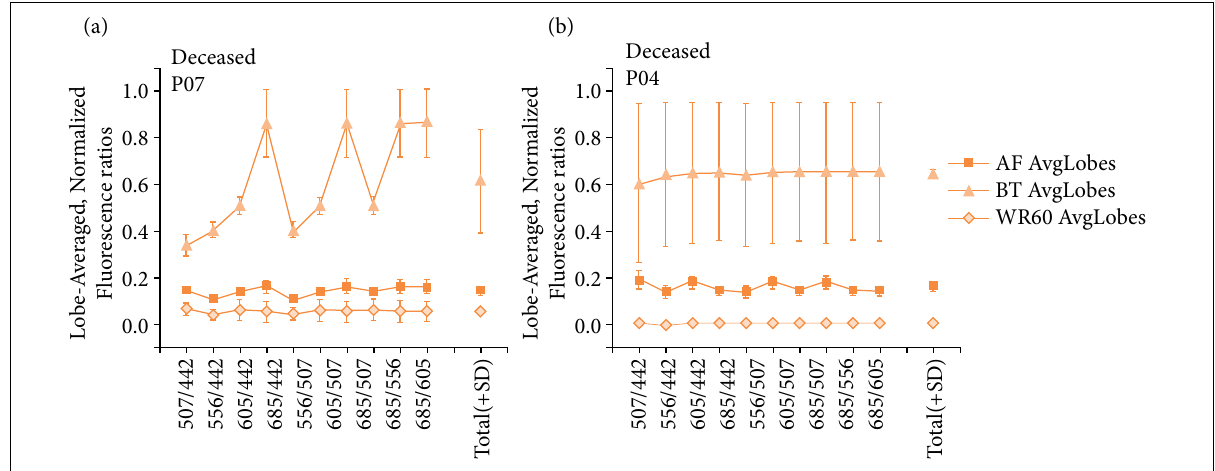
Figure 3 - RBEM of fluorescence for wavelengths 442, 507, 556, 605 and 685 nm: examples of typical results for deceased patients. (a) patient P07 – large difference of the RBEM at BT stage regarding wavelengths; (b) patient P04 – large variance for all RBEM at BT stage regarding the points assessed (represented by standard deviation variance). Wavelengths of choice are related to the emission of the following substances in liver for 408 nm excitation 12 : 442 nm: collagen/elastin, bound reduced nicotinamide adenine dinucleotide phosphate (bound NAD(P)H); 507 nm: